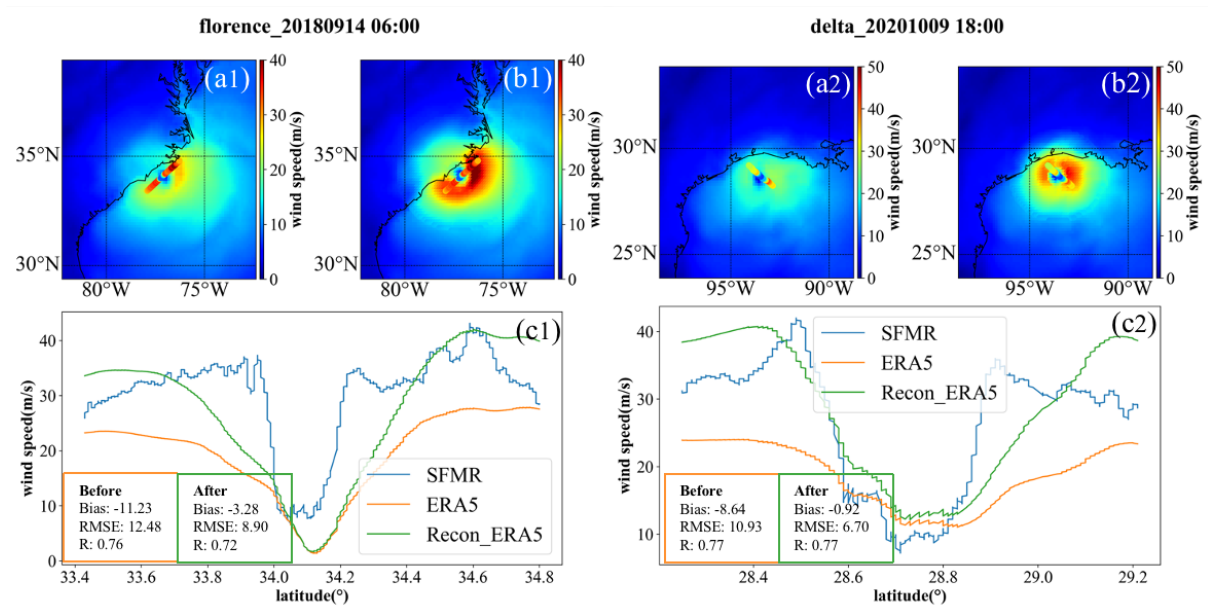
Figure 6. Comparison of wind field ( a1 – b2 ) and profile ( c1 , c2 ) before and after tropical cyclone reconstruction at Florence in 2018 and Delta in